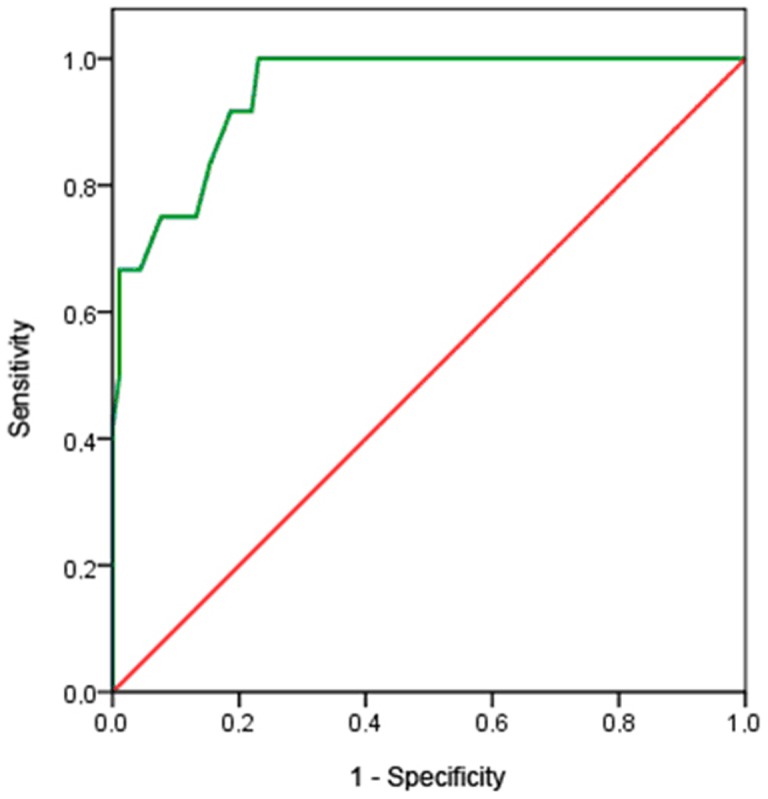
ROC (receiver operating characteristics) curve.